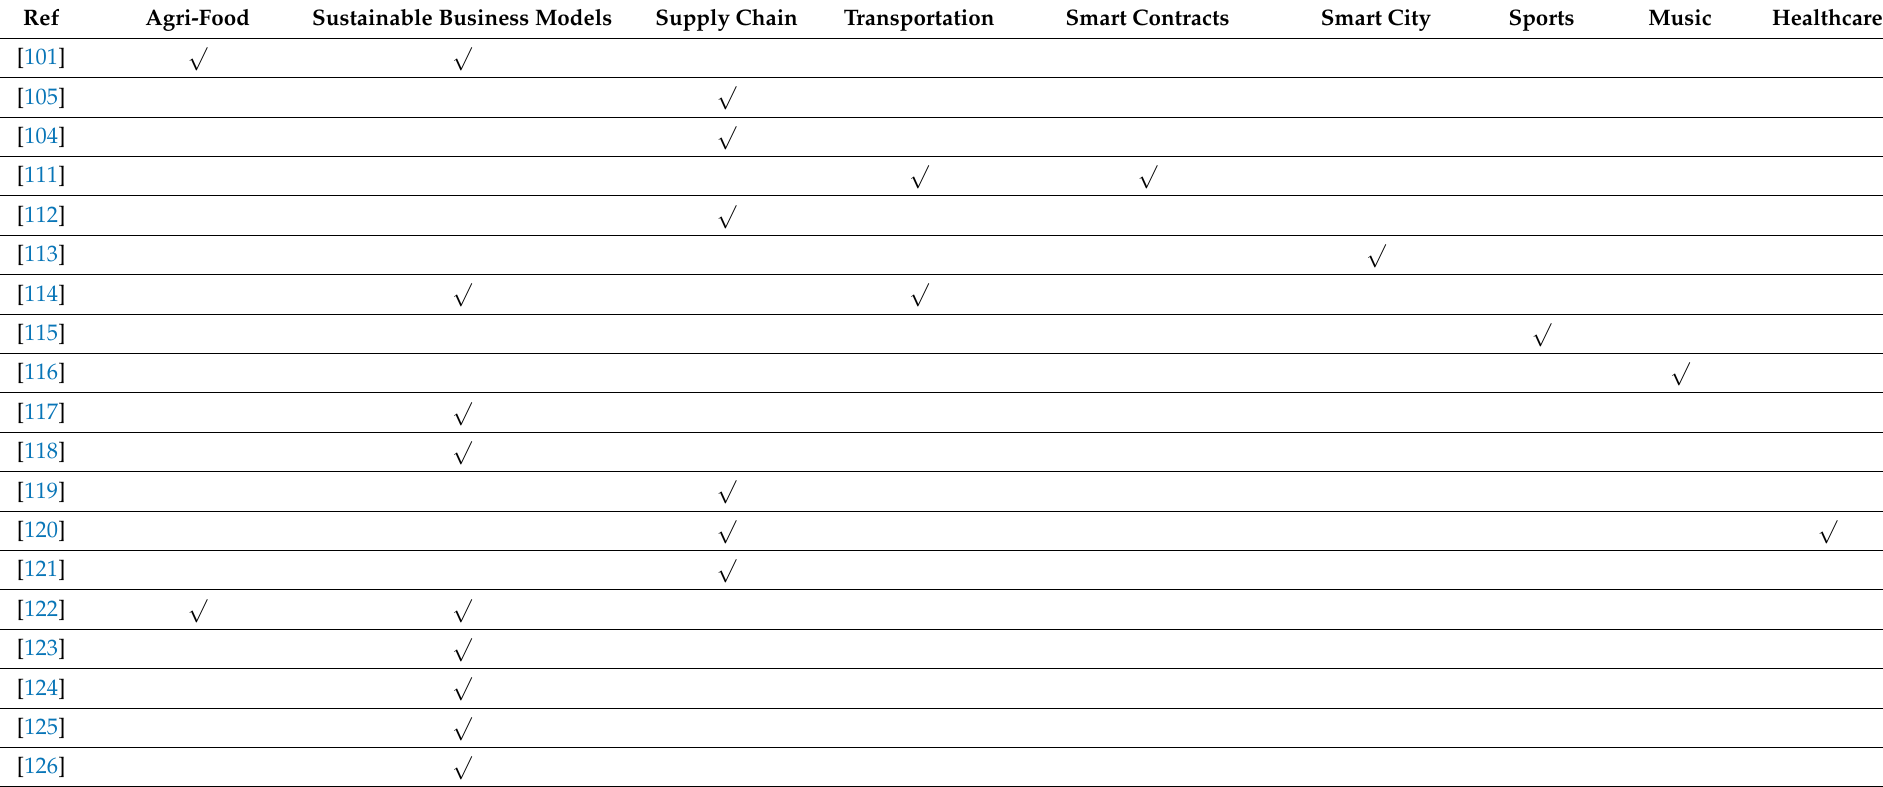
Table 2. Role of blockchain-based business models in some